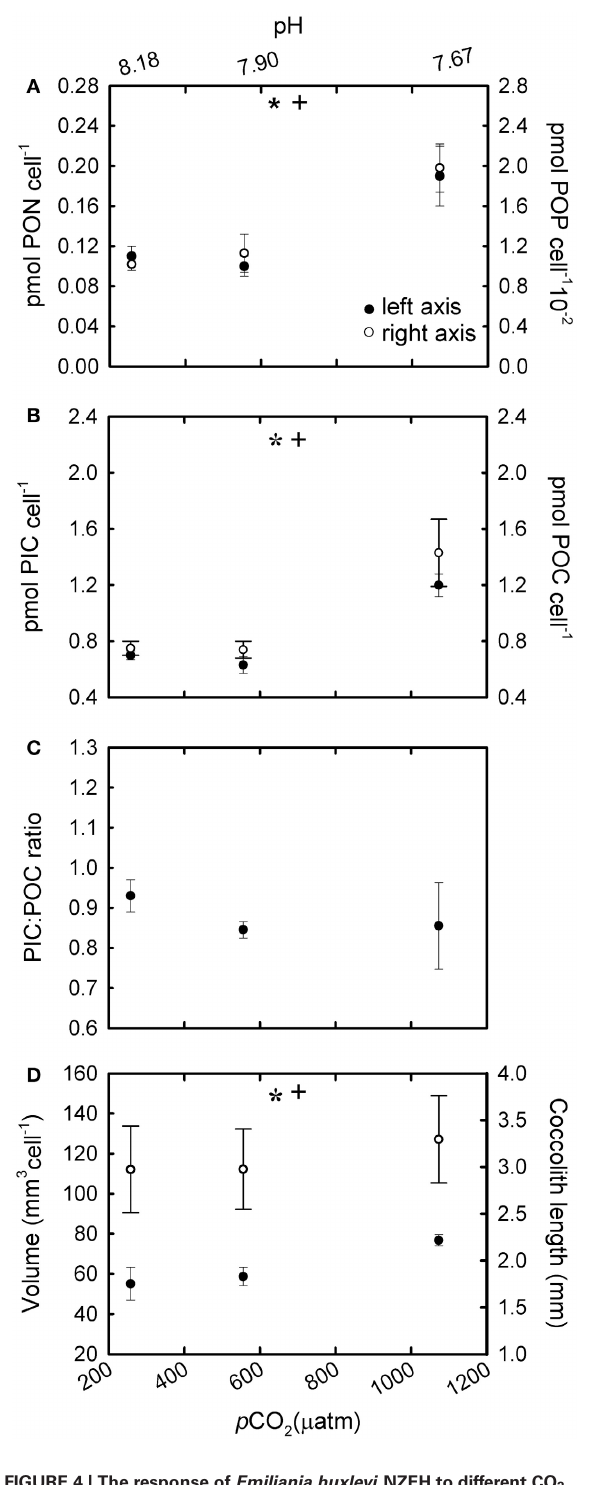
FIGURE 4 | The response of Emiliania huxleyi NZEH to different CO 2 scenarios under nutrient replete conditions. (A) Cellular PON quota, cellular POP quota; (B) Cellular PIC quota, cellular POC quota; (C) PIC:POC; (D) Coccosphere volume ( µ m 3 ) and coccolith length ( µ m). ( ∗ and + ) significant differences ( p < 0 . 05) between CO 2 levels within nutrient treatments from One-Way ANOVA analysis: left ( ∗ ) and right( + )